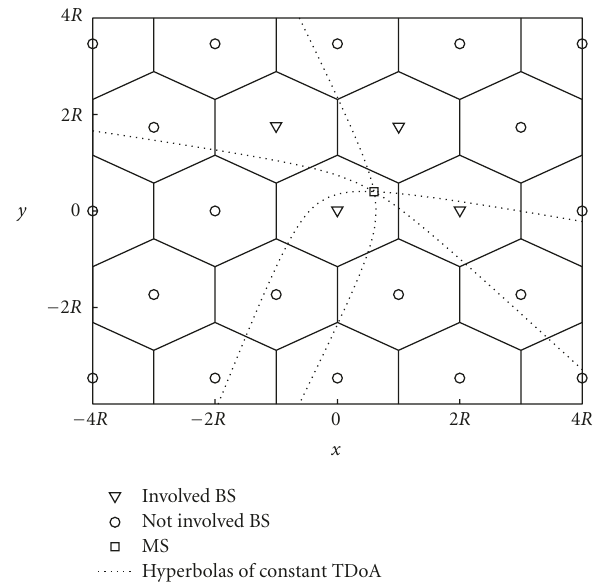
Figure 1: TDoA positioning in cellular networks with N BS = 4 in- volved